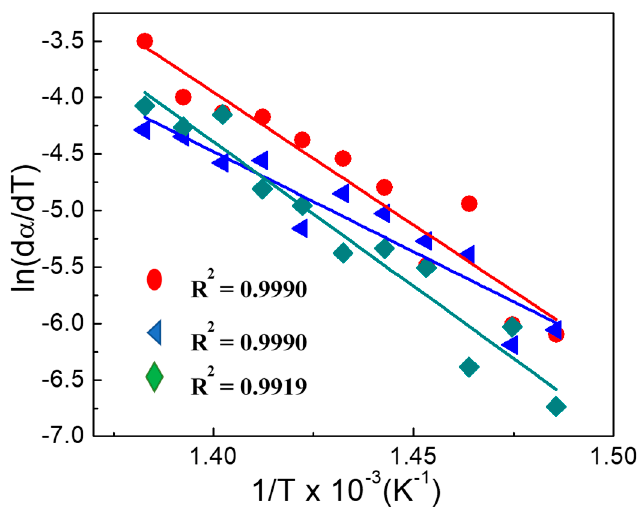
Figure 12. Plot of ln ( d α / dT ) vs. 1 / T for sample PS / Mg2ZnAl_AAC (15 wt.%) at (cid:8) β = 10 ◦ C / min, (cid:74) β =